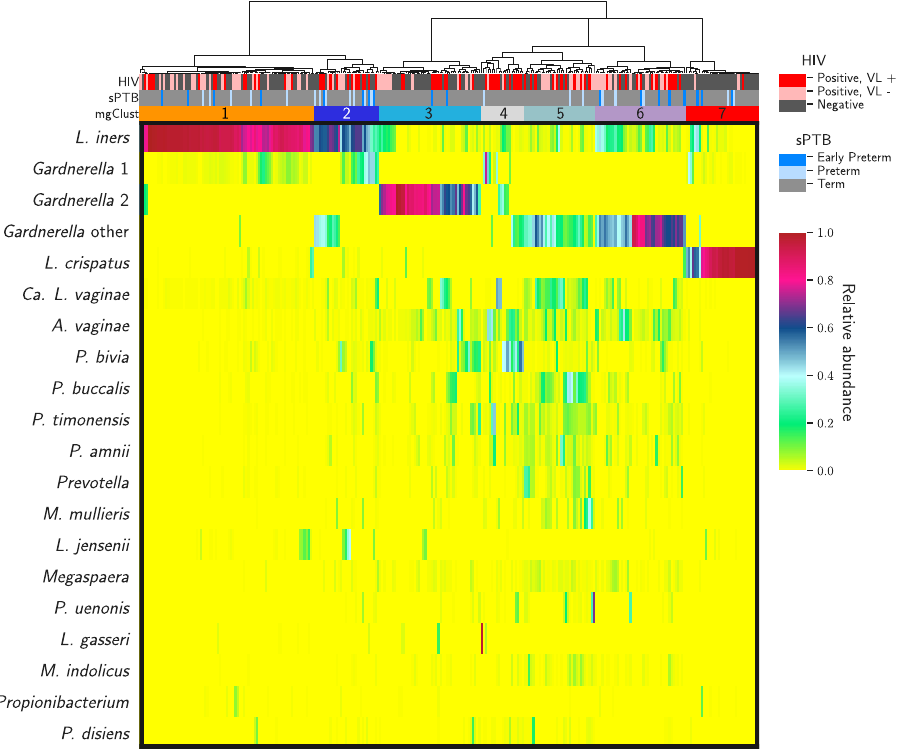
Figure 3. Heat map of vaginal microbial composition of all specimens collected between 16–20 weeks 24–36 weeks, N =